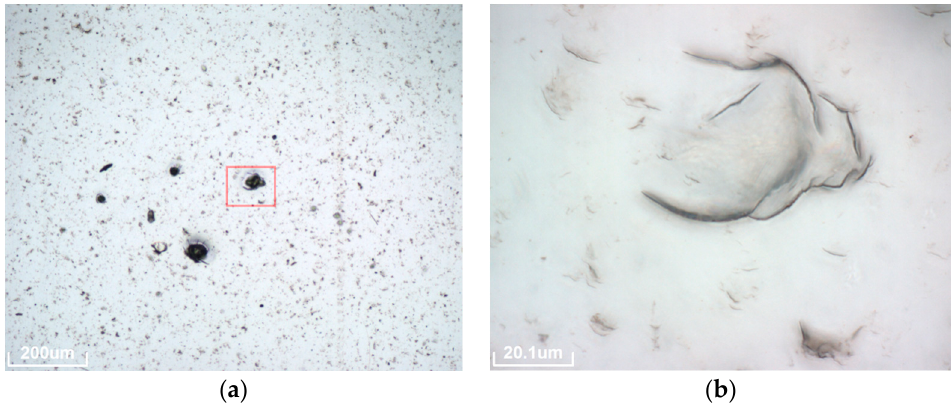
Figure 8. Microscopic view of sand abrasion produced in material A from Zagora, 10× magnification ( a ) and 100× magnification of the red square area in the left picture ( b ).